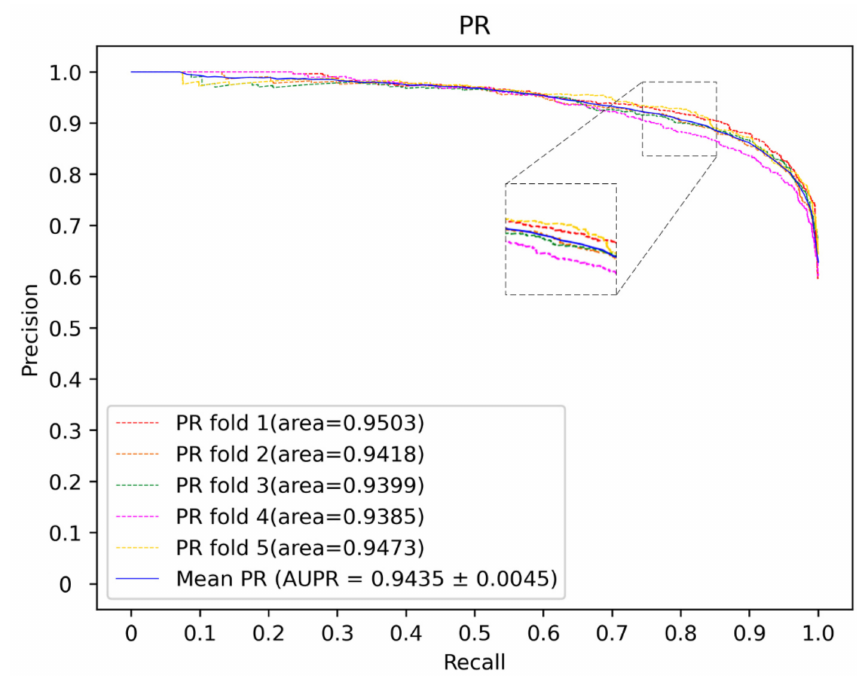
Figure 7. The PR curves of our